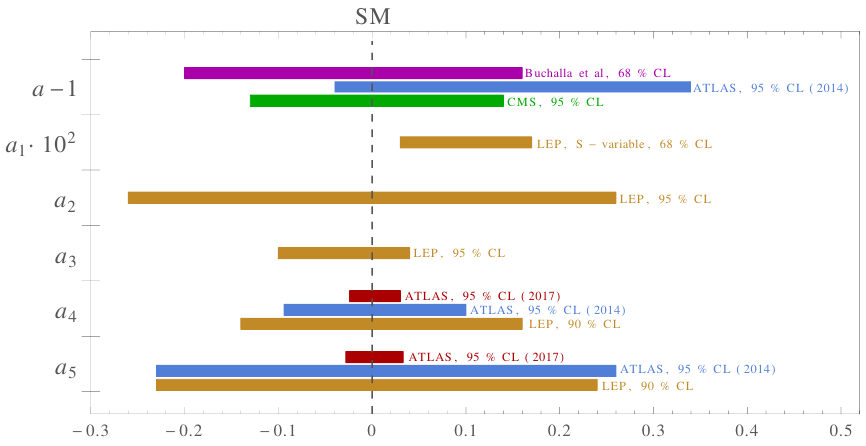
Figure 1 . Present experimental constraints on the EChL coe(cid:14)cients. They are extracted from refs. [23, 27,